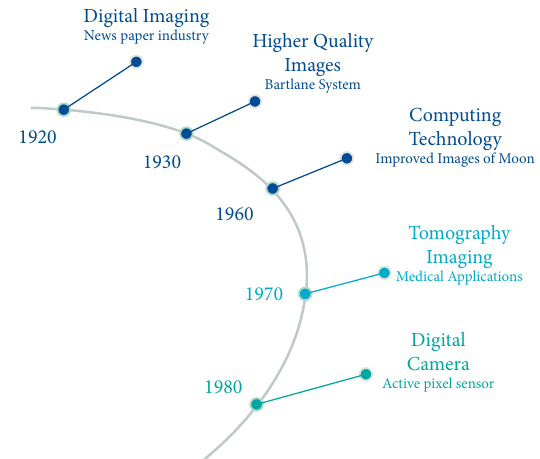
Figure 1: Evolution of image